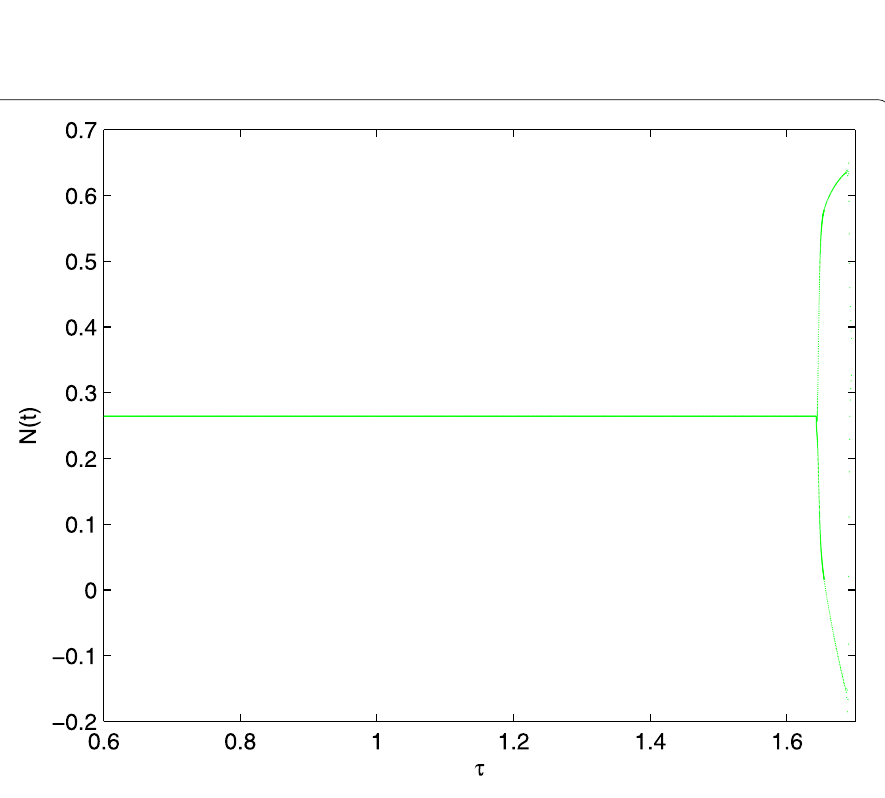
Figure 4 In the case of weak Allee effect, bifurcation diagram of system (3) with respect to